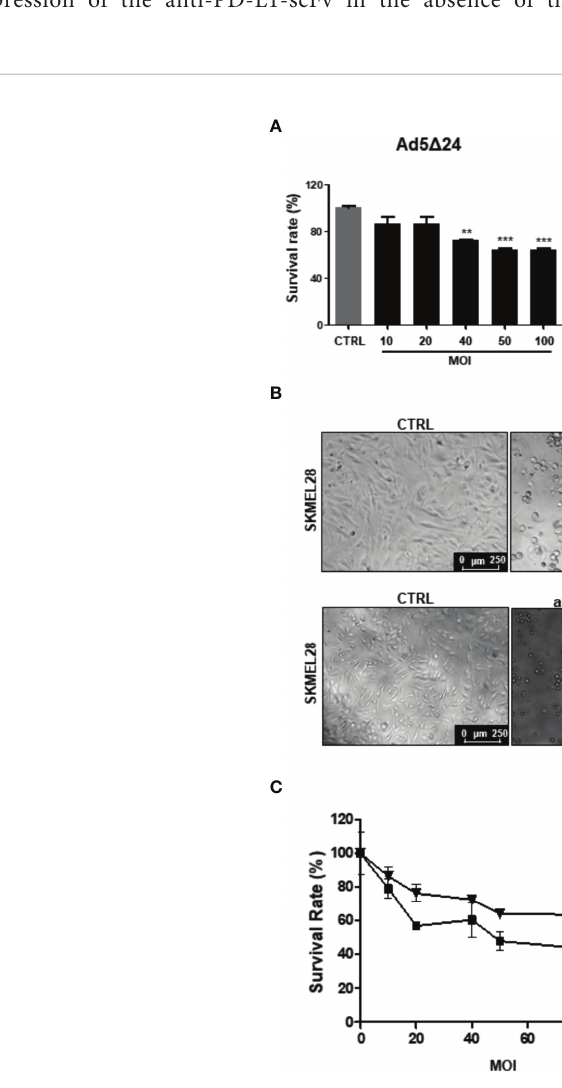
FIGURE 2 | Effects of infection with Ad5 D 24-anti-PD-L1-scFv on human melanoma cell lines SK-MEL28. (A) Human melanoma cells line SK-MEL28 were infected with increasing MOI of Ad5 D 24 (in black) or Ad5delta24-anti-PD-L1-scFv (in white) and cell count was performed at 48 h post-infection. The graphs show the survival rate expressed in the percentage of the cell still alive and compared to the uninfected control. The data were analyzed with GraphPad Prism version 5.02 through One-way analysis of variance with a P-value of <0.0001 for Ad5 D 24 and 0.0026 for Ad5delta24-anti-PD-L1-scFv. The signi fi cance was evaluated with Turkey ’ s Multiple Comparison Test comparing each condition to the un-infected control. In the graph, SEM is reported for each column. (B) Representative images of SK-MEL28 infected with Ad5 D 24 or Ad5delta24-anti-PD-L1-scFv at 48 h post-infection. The images clearly show the cytopathic effect associated with both Ads while absent in the un-infected control. (C) Comparison of survival rate in SK-MEL28 infected with different MOI of Ad5 D 24 or Ad5delta24-anti-PD-L1-scFv at 48 h post-infection. The graphics were obtained through GraphPad Prism 5.02 version. The data were analyzed with GraphPad Prism 5.02 version via T-test with a P- value of 0.1797 indicating that the differences were not signi fi cant (ns). * ≤ 0.05, ** ≤ 0.01 and *** ≤